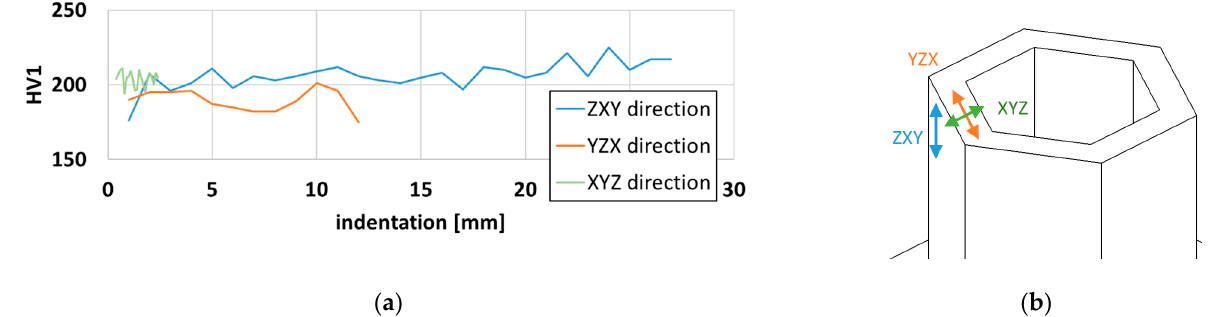
( b ) Figure 7. ( a ) The evaluation area of porosity analysis—ZY plane (parallel to build direction), ( b ) Results of porosity analysis—pore of the largest diameter (40.86 µm) found in the structure observed using light microscopy. The hardness HV1 was evaluated by a laboratory hardness tester Struers Durascan 50 (EMCO-TEST Prüfmaschinen GmbH, Kuchl, Austria) with a normal force of 9.807 N.